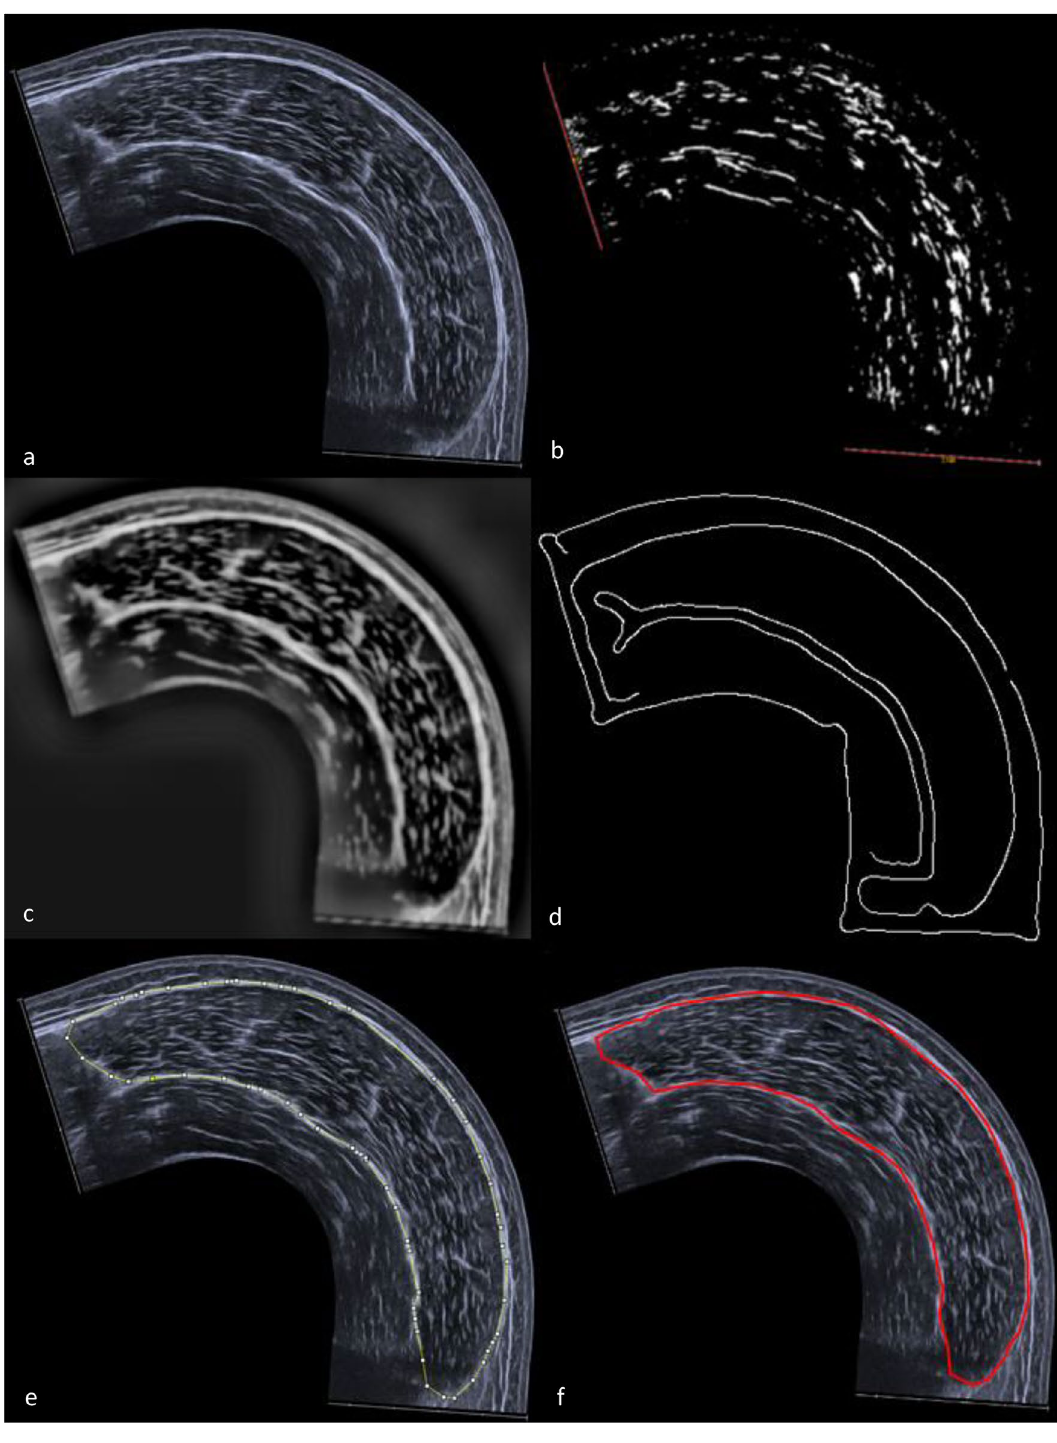
Figure 1. Workflow of the ACSAuto script: ( a ) raw Image, ( b ) automatic scaling using ridge detection plugin with red objects representing detected lines, ( c ) pre-processed Image, ( d ) mask for outline detection, placement of outline-finder starting points and removal of artefacts, ( e ) suggested muscle outlines, ( f ) measured